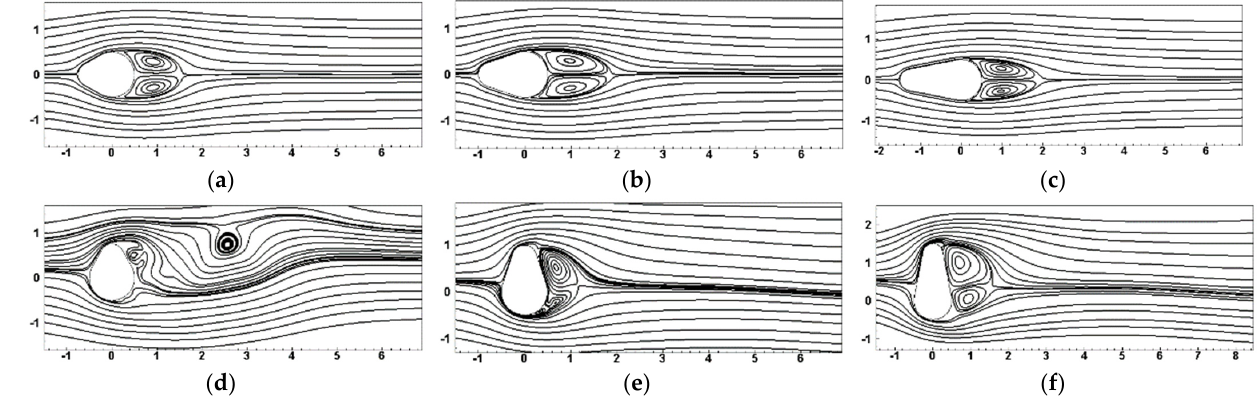
Figure 7. Time-averaged streamlines for different icing thickness. ( a ) 0.25D-0° ( b ) 0.5D-0° ( c ) 1.0D-0° ( d ) 0.25D-90° ( e ) 0.5D-90° ( f ) 1.0D-90°.